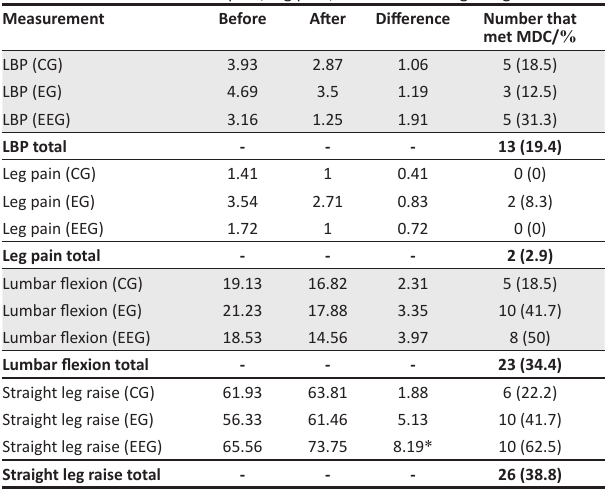
TABLE 2: Results for low back pain, leg pain, flexion and straight leg raise.